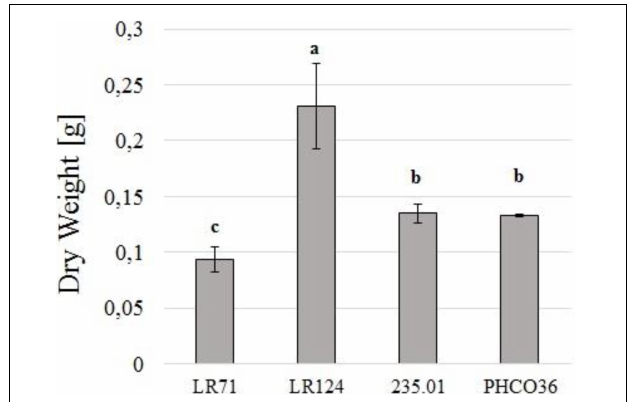
FIGURE 3 | Dry weight of filtered liquid culture of 4 strains of Fmed (PHCO36, LR124, 235.01, LR71) grown at 28 ◦ C for 10 days in the dark. Cultures grown in 125 ml of Eriksson and Pettersson’s medium in the presence of cellulose and grapevine wood sawdust. Dried matter including everything was retained by 0.2- µ m filtration. Statistical differences were calculated by ANOVA analysis ( p ≤ 0.05), and letters above histograms indicate different statistical groups determined by Tukey’s test; error bars on histograms represent the standard error of the mean.